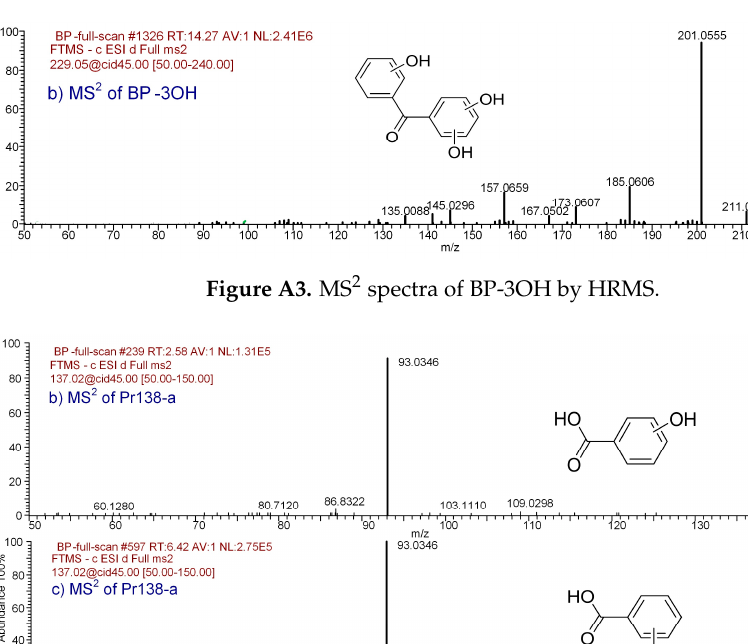
Figure A2. MS 2 spectra of BP-2OH-a and BP-2OH-b by HRMS.